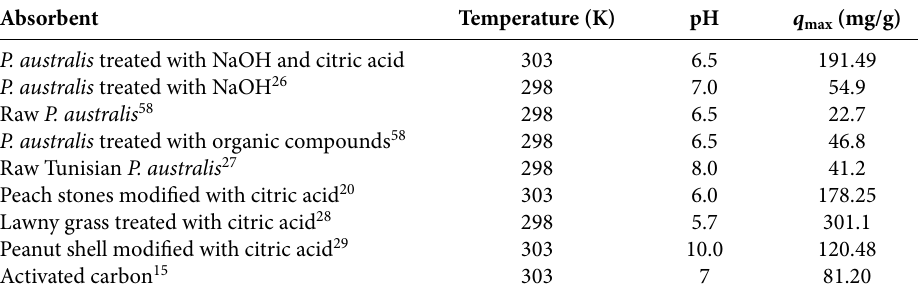
Table 6. MB adsorbents’ capacities in